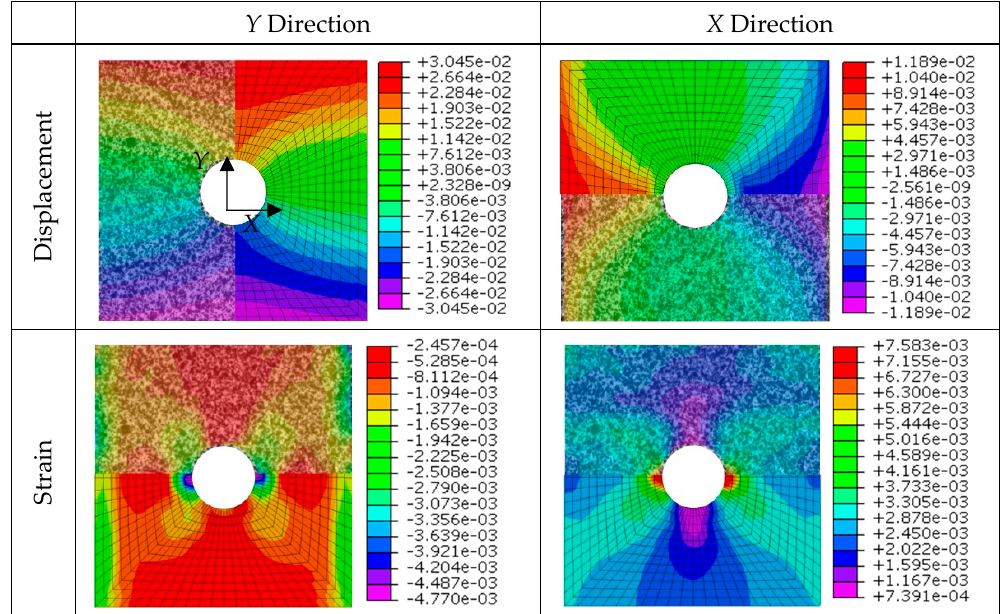
Figure 13. Comparison of displacement and strain fields between DIC estimation and numerical prediction for geometry A.